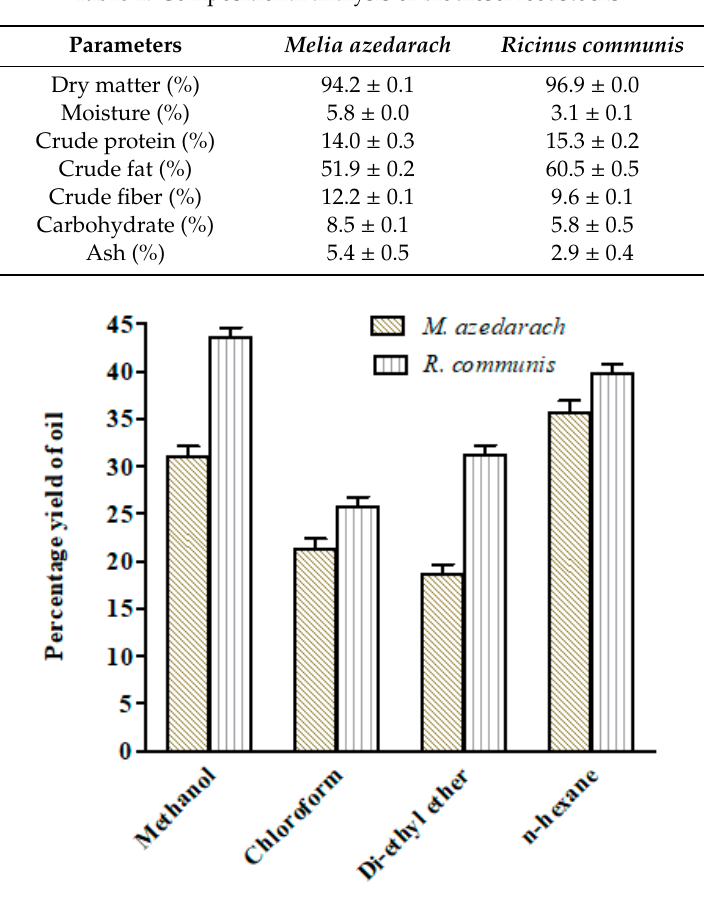
Table 1. Compositional analysis of biodiesel feedstocks.